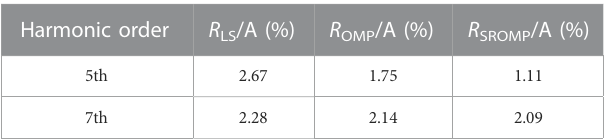
TABLE 2 Relative error.